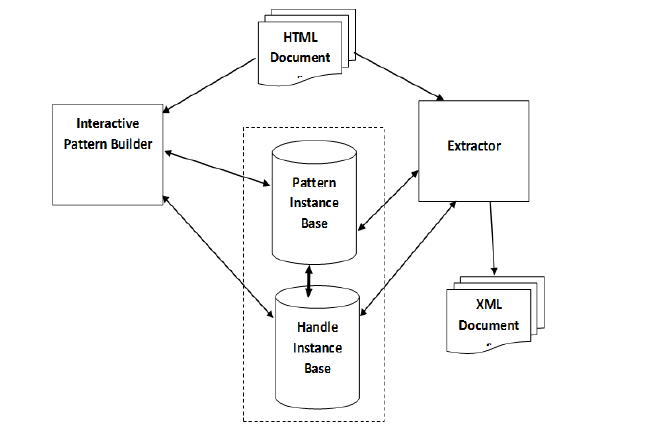
Figure 3. Architecture of